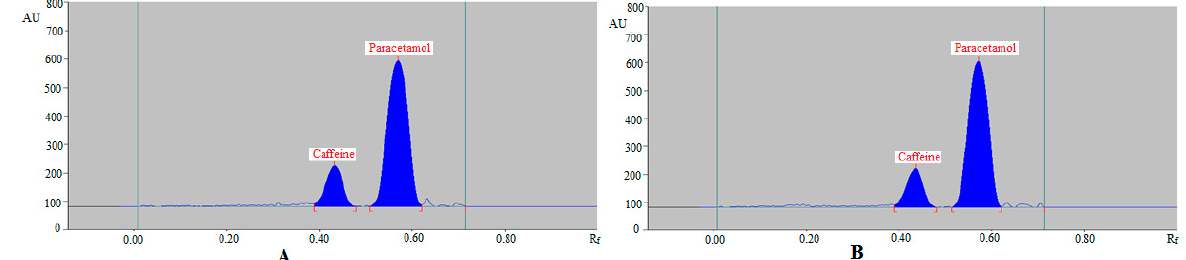
Figure 7. Reversed ‐ phase HPTLC chromatograms of caffeine and paracetamol in ( A ) commercial Figure 7. Reversed-phase HPTLC chromatograms of caffeine and paracetamol in ( A ) commercial tablets PANEXT and ( B ) commercial tablets SAFEXT. tablets PANEXT and ( B ) commercial tablets